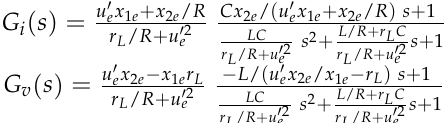
Figure 9. Two-loop cascade current-mode control structure.